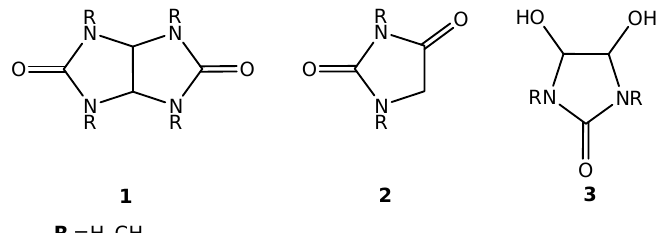
Figure 1. Structures of glycolurils 1 , hydantoins 2 and 4,5-dihydroxy-2-imidazolidinones